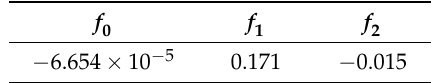
Table 8. Regression coefficients for calculating ULR.